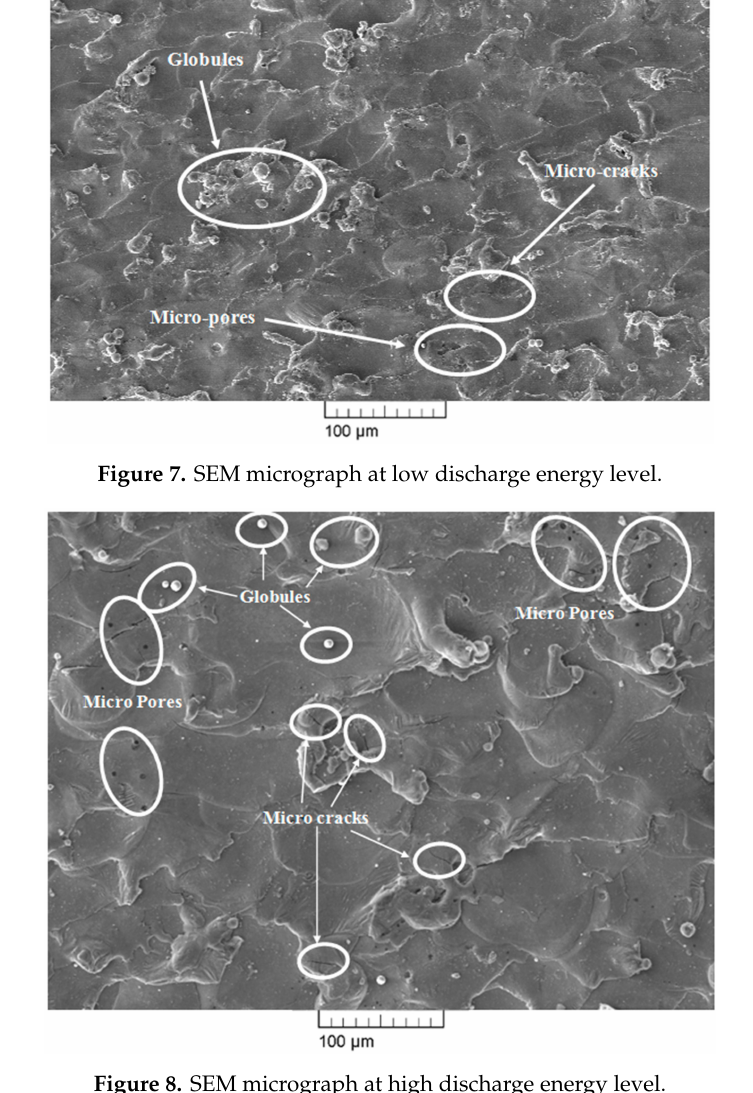
Figure 8. SEM micrograph at high discharge energy